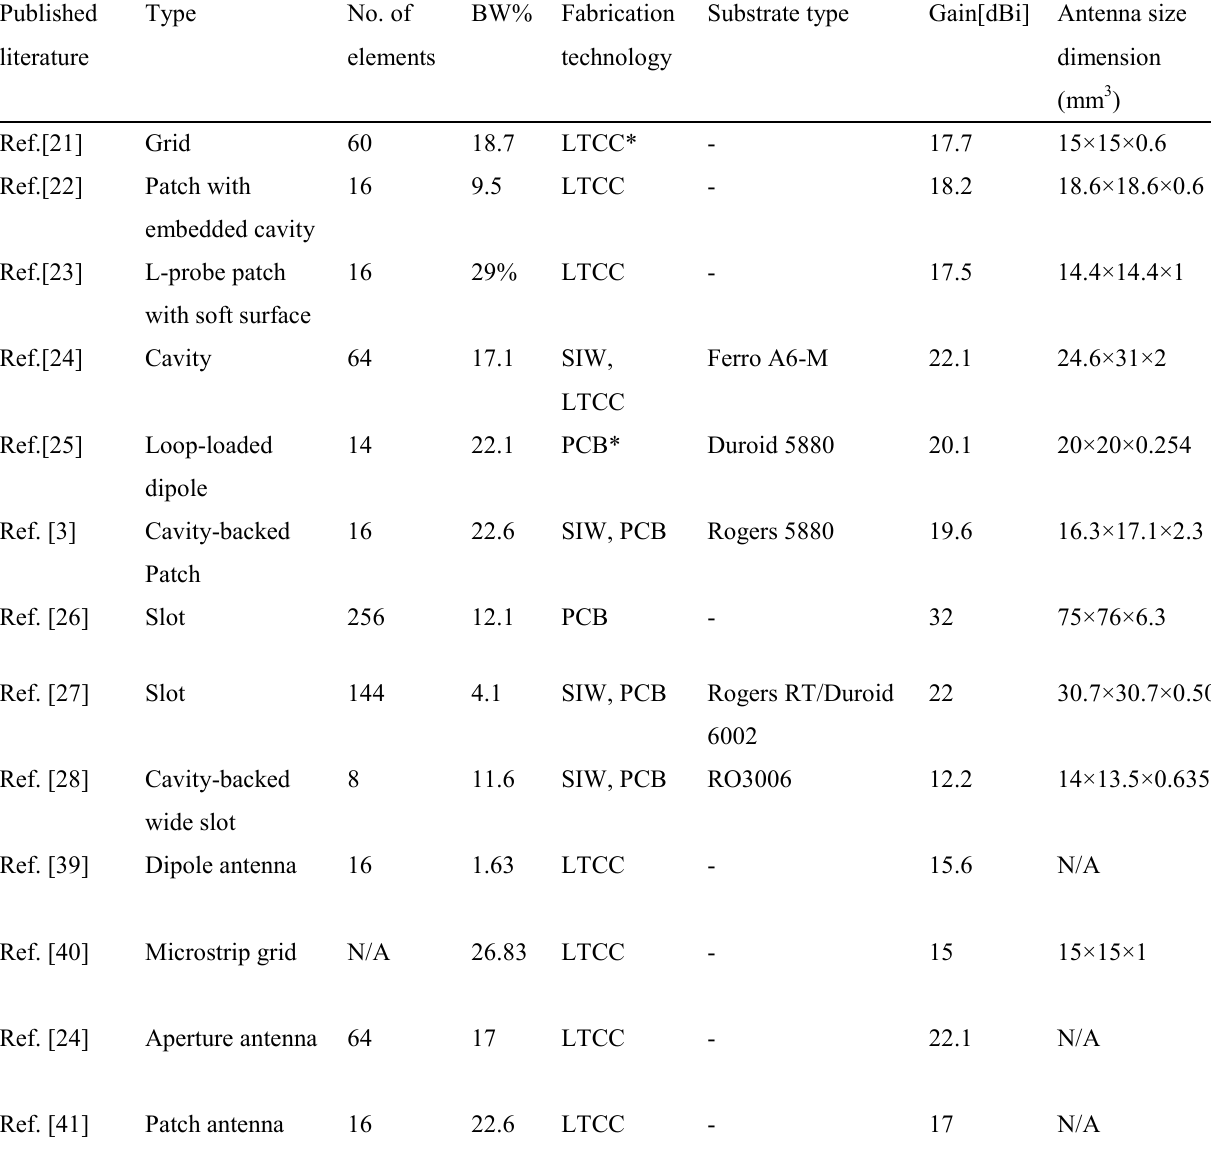
Table 2: Linear polarization for 60 GHz